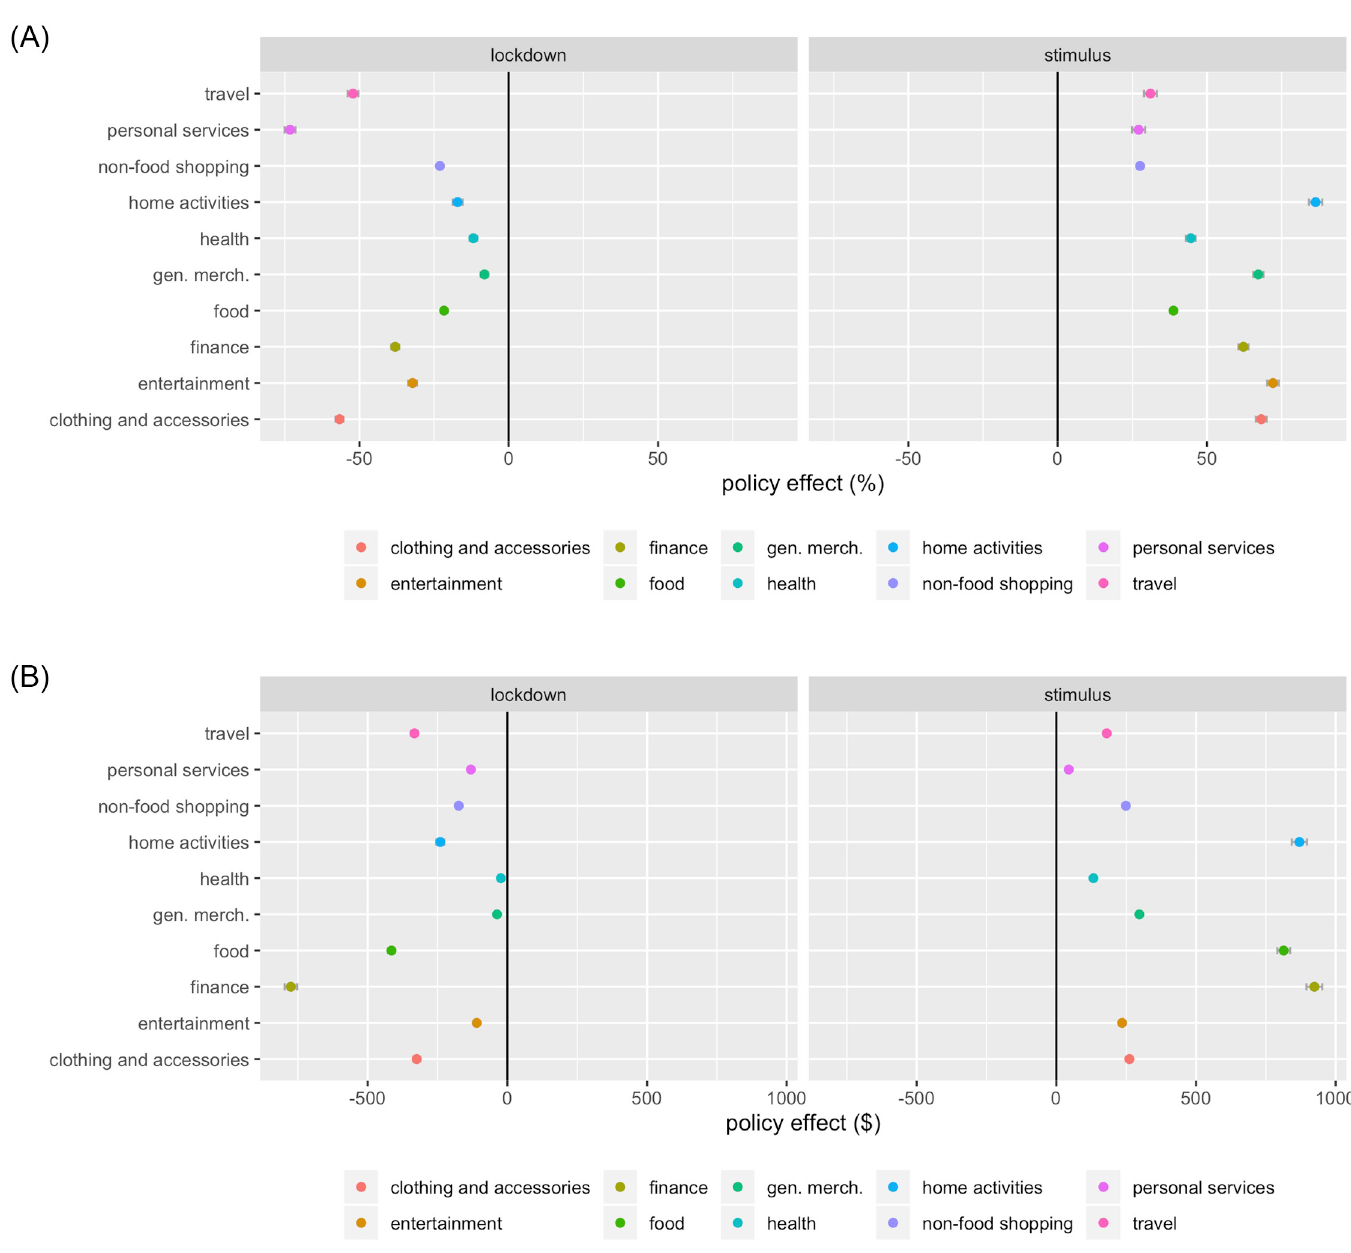
Fig 4. Effects of initial lockdown and stimulus payments by major spending group. (a) Effects on percentage change. (b) Effects on dollar change.